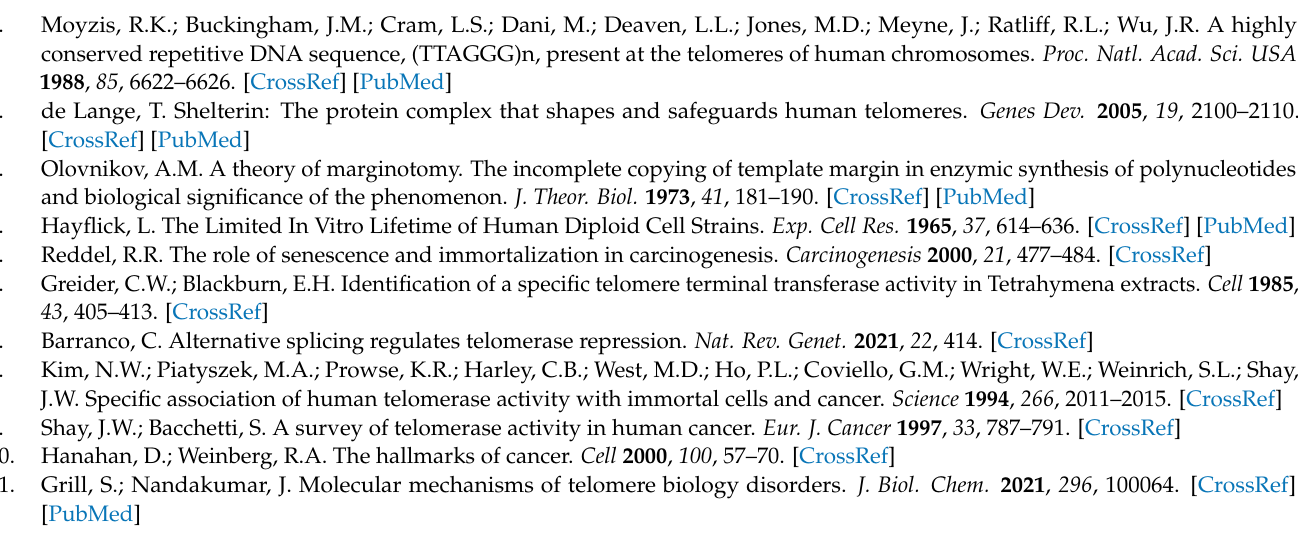
ments; Figure S1: Sequence alignment of several TERT homologs. Figure S2: Structural alignment of hTERT and tcTERT; Figure S3: Single-turnover kinetics reaction progress curves; Figure S4: Residue 194’s interactions with the incoming nucleotides triphosphate and